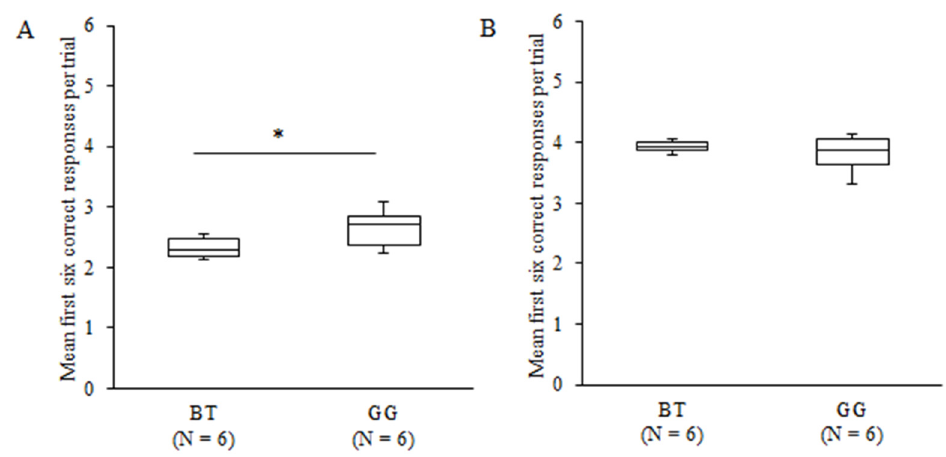
Figure 9. Search order analysis on the mean of the first six correct responses per trial for pattern A ( A ) and pattern B ( B ). * p < 0.05.